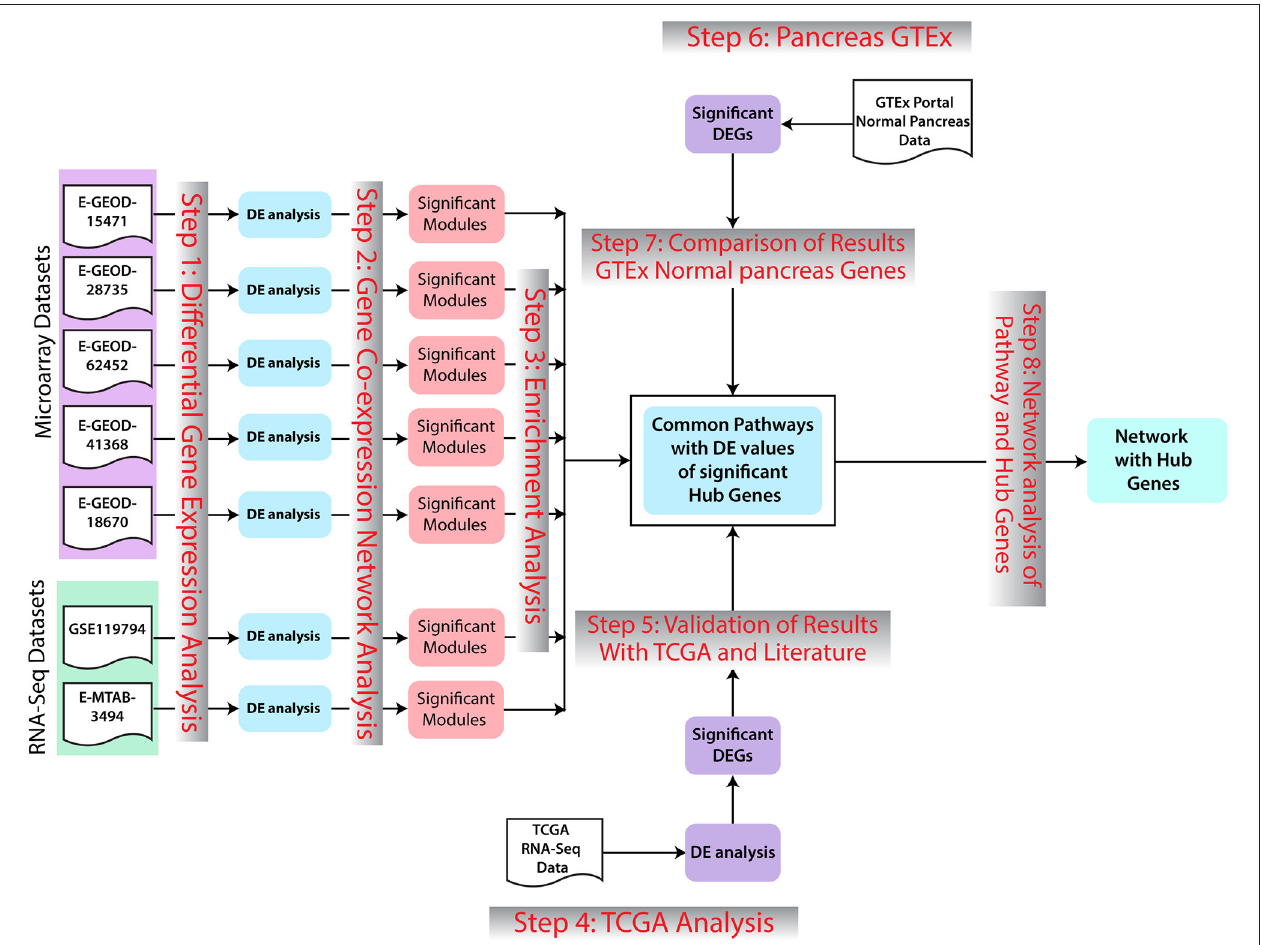
FIGURE 1 | Methodology workflow. In the first step, differential expression analysis was performed to identify significant differentially expressed genes (DEGs). Afterward, for further analysis of genomic data, co-expression network analysis of DEGs with − 0.5 > log 2 FC > 0.5 was preformed. Significant modules for each dataset were selected. Enrichment analysis of genes of selected modules was preformed. Additionally, the common pathways in all datasets were further studied regarding pancreatic cancer (PaCa) development. Results were validated with The Cancer Genome Atlas (TCGA) cohort analysis, GTEx Portal, and literature. In the last step, gene network interaction analysis and hub genes identification were